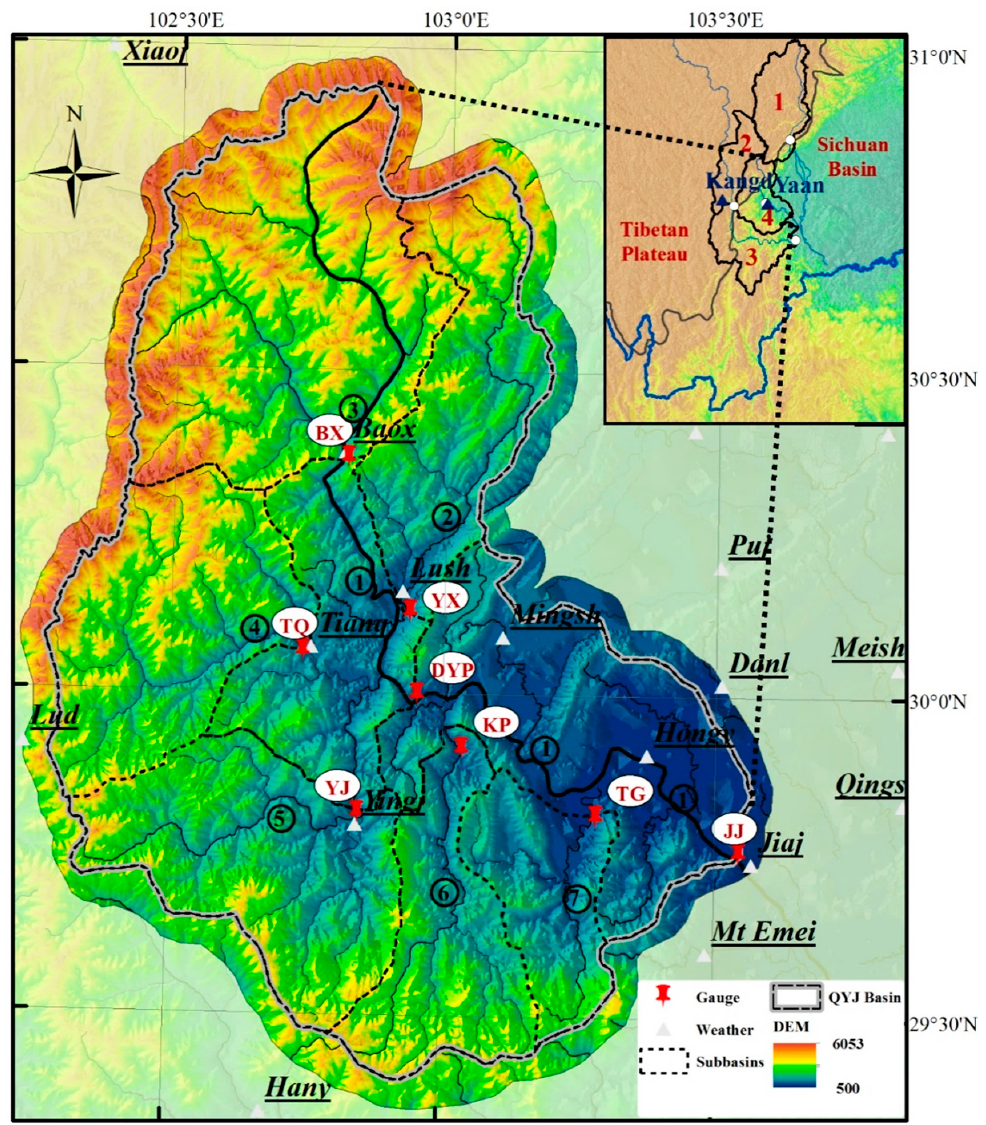
Figure 1. The geomorphology and rivers in the QYJ Basin. The numbers 1–7 in the circle respectively denote the QYJ River, Yuxi River, Baoxing River, Tianquan River, Yingjing River, Zhougong River, and Huaxi River. The labelled basins in the upright inset panel are respectively the Minjiang Basin (1, with the outlet at ZPB gauge), the middle Daduhe Basin (2, LD gauge), the lower Daduhe Basin (3, FL gauge), and the QYJ Basin (4, JJ gauge).